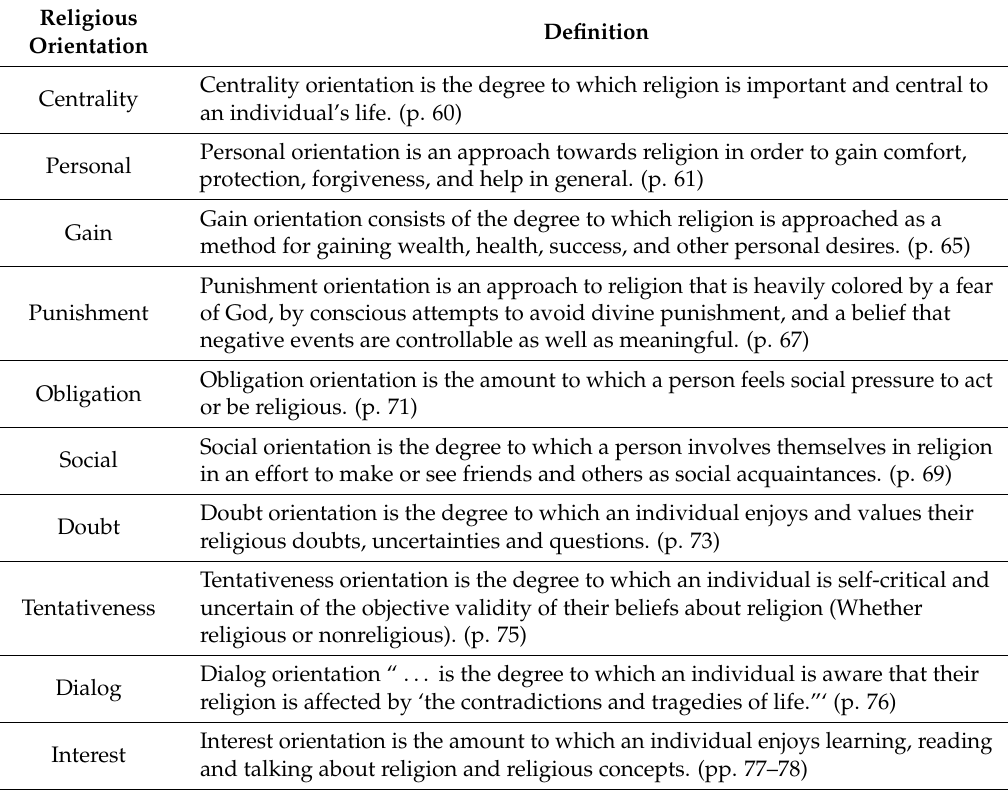
Table 2. Definitions of the CROI Orientations.